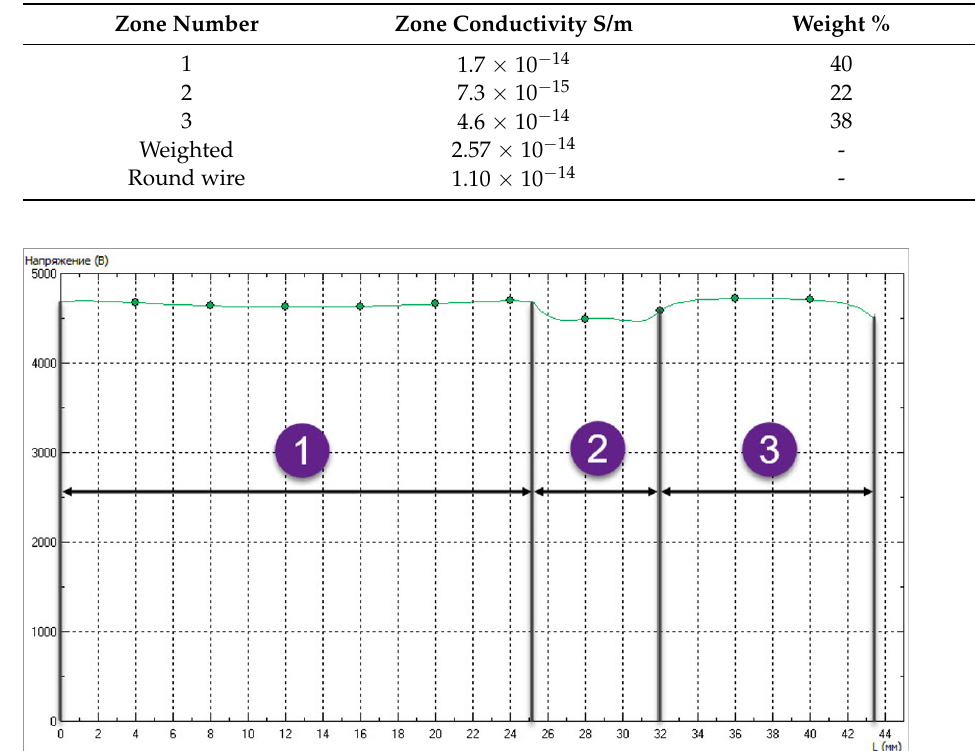
Figure 3. Potential distribution along the conditional external (upper) boundary of the model region.